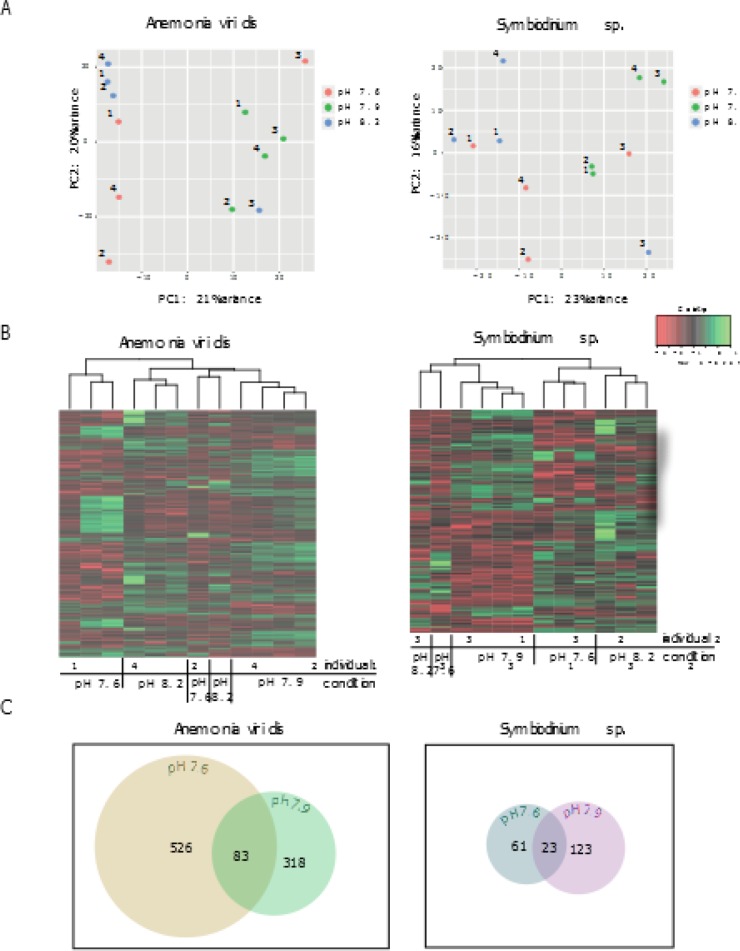
Differential gene expression profiles of Anemonia viridis and Symbiodinium sp. at the sampling sites.Differential expression (DE) pipeline using a glm edgeR approach was applied to account for both the day of sampling and the different pH where samples were taken. The DE analysis was performed separately for A. viridis and Symbiodinium sp. (A) Principal component analysis (PCA) plots show clustering similarity of individual samples. Numbers in the PCA plots represent different individuals sequenced. (B) Shown are heatmaps with hierarchically clustered, significantly differentially expressed (DE) transcripts between the sampling sites separately for A. viridis and Symbiodinium sp. (C) Venn diagrams visualize the number of private and shared DE-transcripts at pH 7.6 and pH 7.9 compared to normal conditions (pH 8.2). A. viridis contained 526 private DE-transcripts at pH 7.6 and 318 private DE-transcripts at pH 7.9. The symbiont contained 61 and 123 private DE-transcripts at pH 7.6 and pH 7.9, respectively. Venn diagrams were created using venneuler in R software.